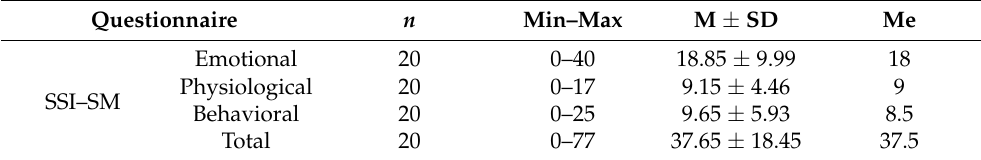
Table 2. Stress obtained total values of 37.65 ± 18.45. Table 2. Descriptive statistics of